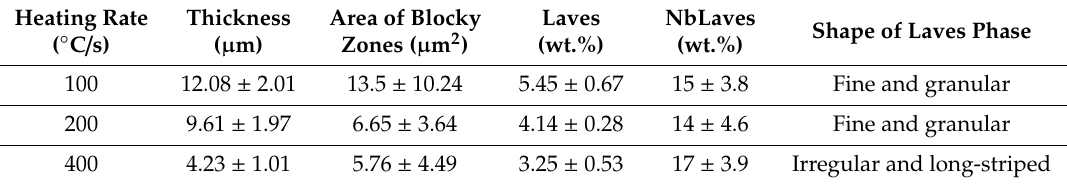
Table 5. Microstructural characteristics of the SLMed IN718 for di ff erent heating rates.